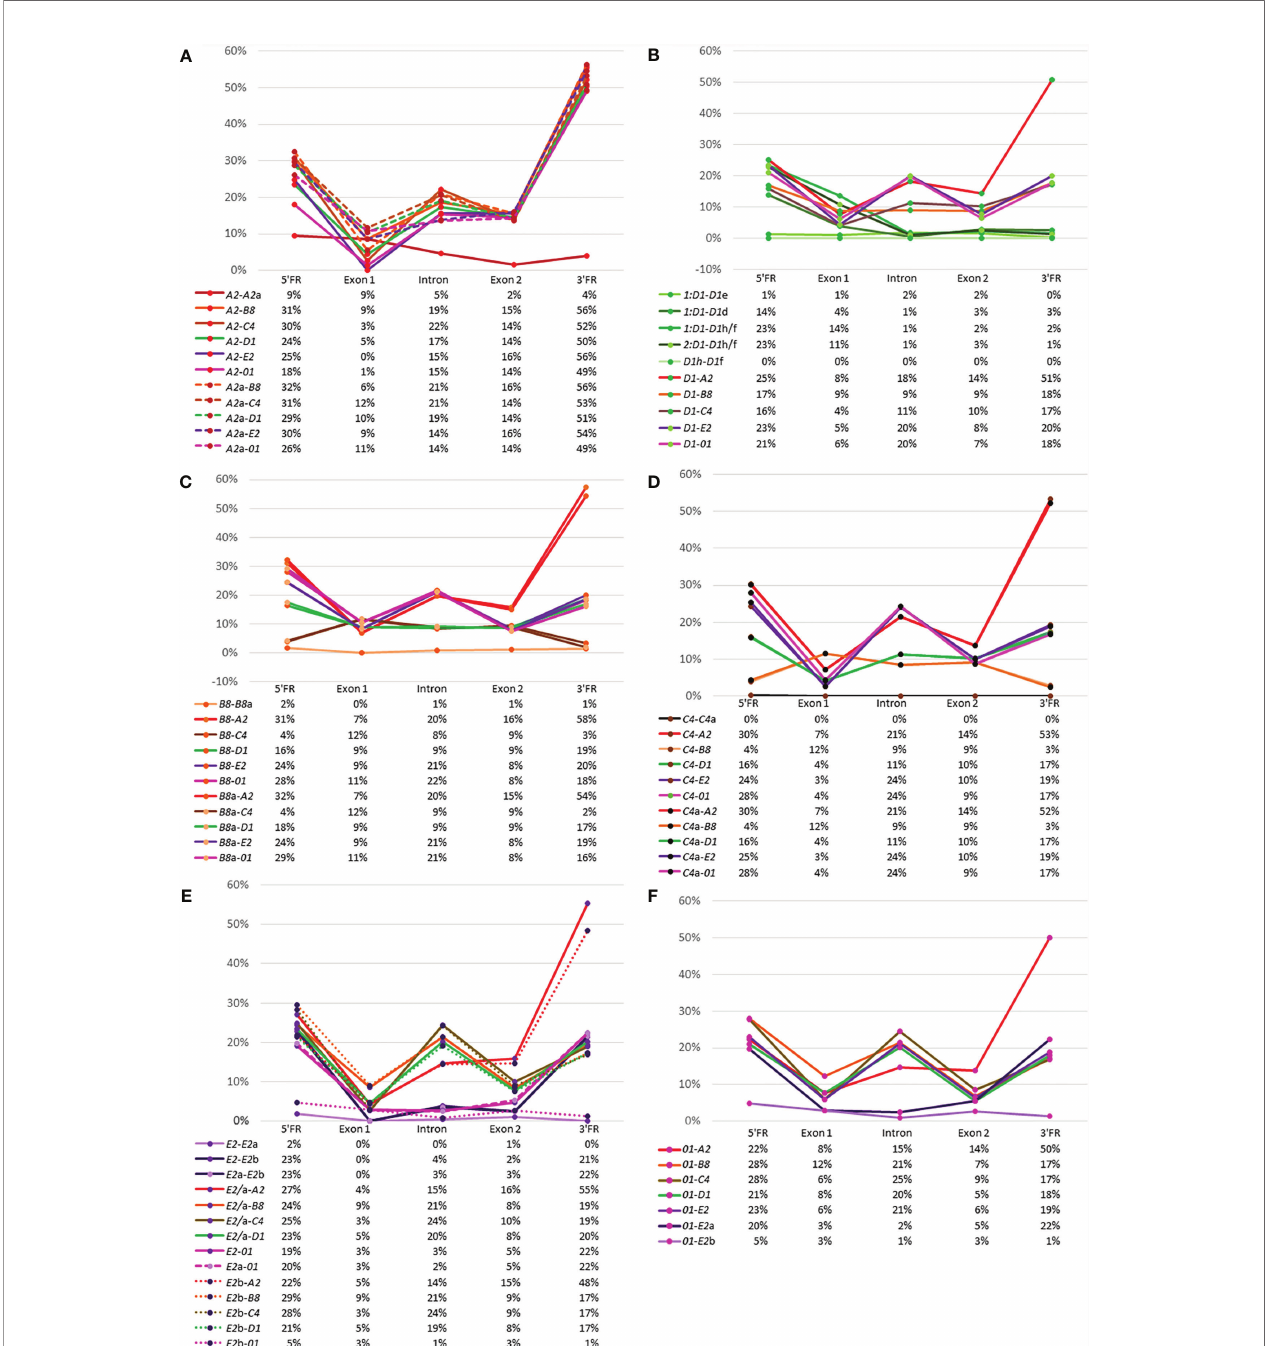
FIGURE 5 | Relatedness among the genes can be inferred from percent mismatch scores for the 5 ʹ FR, exon 1, the intron, exon 2, and the 3 ʹ FR. Pairwise comparisons among all genes are shown for the FRs, exons, and the intron. The X axis in the graphs indicates the calculated percent mismatch score for each pair of genes and the Y axis indicates the region in the gene. Solid lines, dashed lines, and dotted lines are used to identify the pairs of genes compared. The color of the line corresponds to the color of the genes shown in Figure 1A with the exception of the D1 genes, which are all shown as green lines. Below each graph is a table that gives the percent mismatch scores for each region graphed above. (A) The A2 genes vs . other SpTrf genes. (B) The average percent mismatch of D1 genes vs . other SpTrf genes. (C) The B8 genes vs . other SpTrf genes. (D) The C4 genes vs . other SpTrf genes. (E) The E2 genes vs . other SpTrf genes. (F) The 01 genes vs . other SpTrf genes. Percent mismatch [pairwise distance/Ln 2 ] was calculated from the pairwise distance matrix scores generated with MEGA7 using the PRANK codon